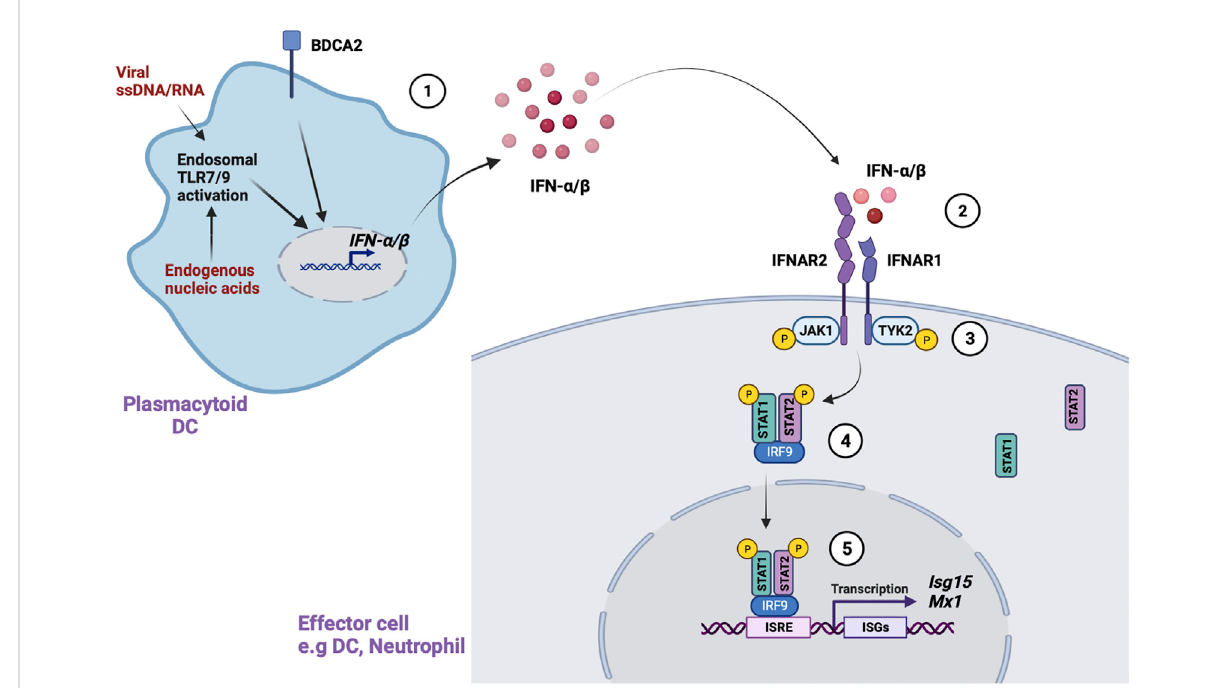
FIGURE 1 Type 1 IFN signaling. Type 1 IFN signaling is mediated through several steps. (McCarty et al., 1995). Activation of endosomal TLR7/9 by viral ssDNA/RNA or endogenous nucleic acids in pDCs leads to IFN- α / β production. Activation of an important receptor, BDCA2, also promotes IFN- α / β production(Izmirlyetal.,2017).Inthecanonicalpathway,IFN- α / β bindstotheIFN- α receptor(IFNAR)inIFNresponsivecells(Izmirlyetal.,2021).This leads to phosphorylation and activation of IFNAR associated JAKs (JAK1, Tyk2) (International Consortium for Systemic Lupus Erythematosus et al., 2008). The activated JAKs phosphorylate STAT1/STAT2, which form a heterodimer that further complexes with IRF9 in the cytoplasm (Hom etal., 2008). Finally, theSTAT1-STAT2-IRF9 complex translocates to thenucleus, binds to conserved IFN-stimulatedresponse elements (ISREs), and leads to transcription of IFN stimulated genes